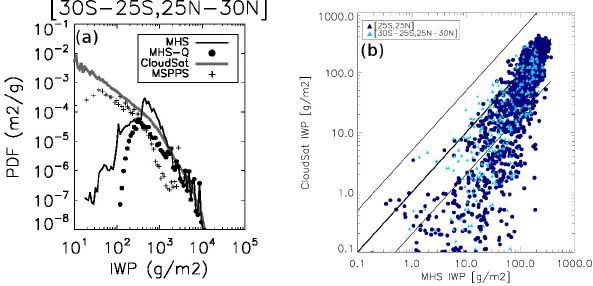
Figure 9. (a) is the same as Fig. 6, except from different latitude bins (see sub-titles for the latitude range). (b) is the scatter plot of MHS (abscissa) and CloudSat (ordinate) gridded monthly mean IWP for latitude bins between [ 25 ◦ S, 25 ◦ N] (blue filled dots), [ 25 ◦ , 30 ◦ ]N, and S (light blue triangle). The map grid size is 5 ◦ × 5 ◦ , and data are then smoothed by a two-point window along latitude and longitude before making the scatter plot. The black thick (thin) line marks the 1:1 (1:5 and 5:1)